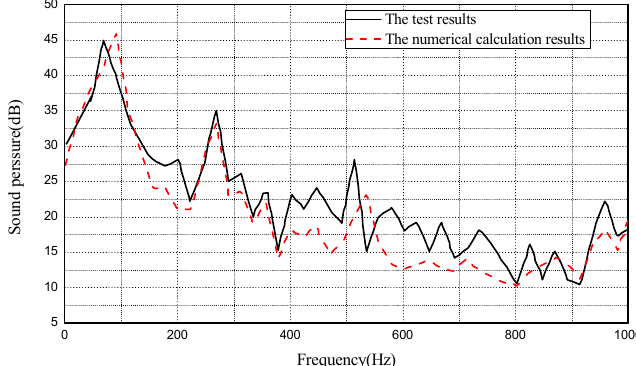
Figure 1. The comparison curve between the numerical simulation and the experimental test. The dark line denotes the preliminary test, and the red line denotes the numerical calculation. The frequency is in the range from 0 to 1000 Hz. The reference sound pressure level is 20 uPa.